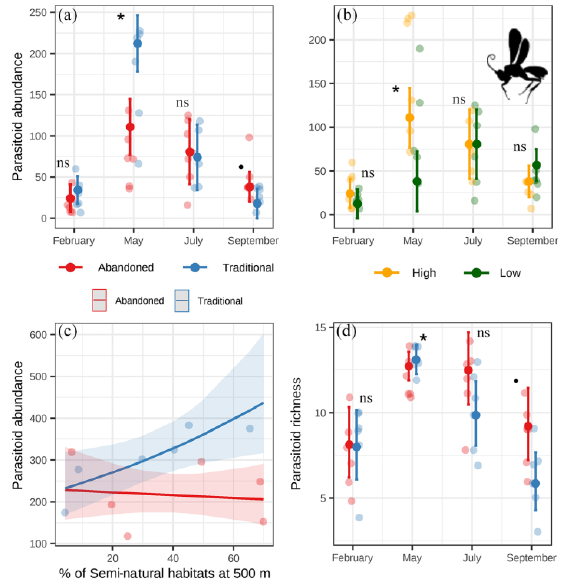
Figure 5. Results of the linear models for parasitoid abundance ( a – c ) and richness ( d ). Points with error bars represent estimated means and 95% confidence intervals from the models’ predictions, and dull dots represent the raw data. Significant ( p < 0.05) differences are shown with asterisks and marginally significant (0.05 < p < 0.1) differences with dots. ns: not significant.